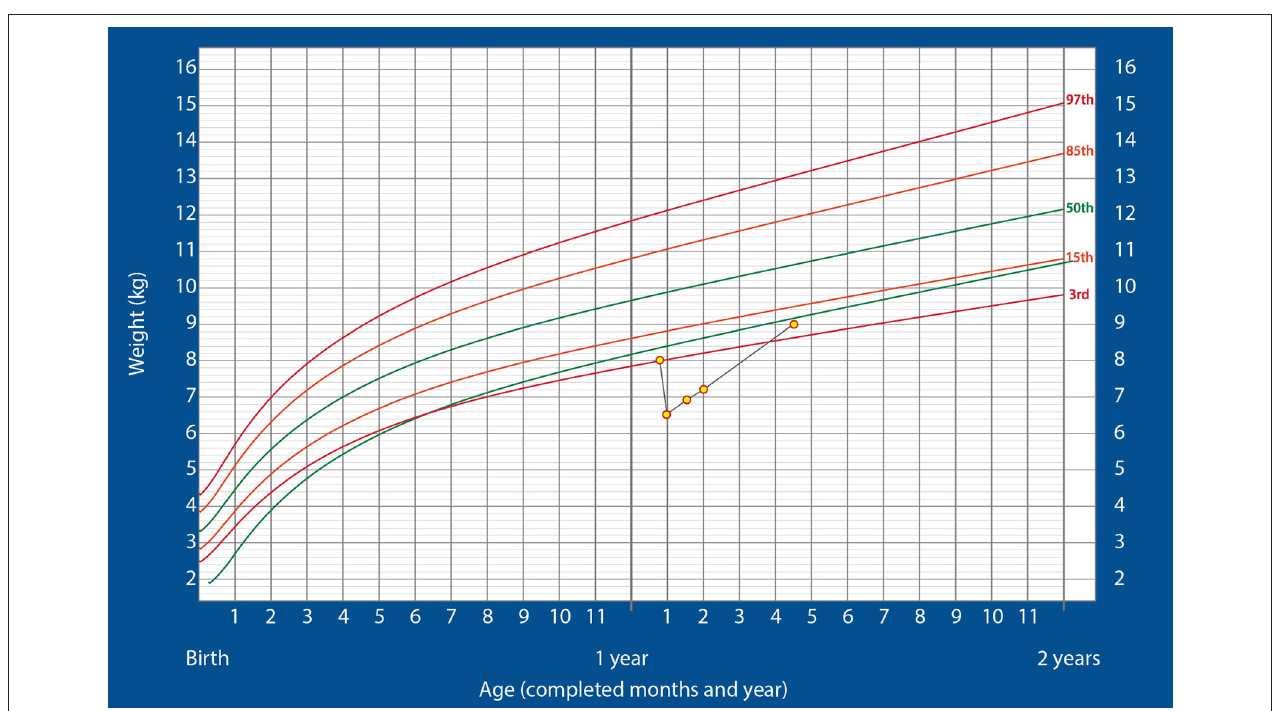
FIGURE 2 | Changes in the weight of the infant over time, plotted on the standardized WHO weight-for-age growth chart for boys (Case 2).